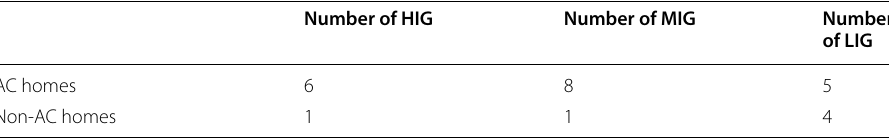
Characteristics of homes